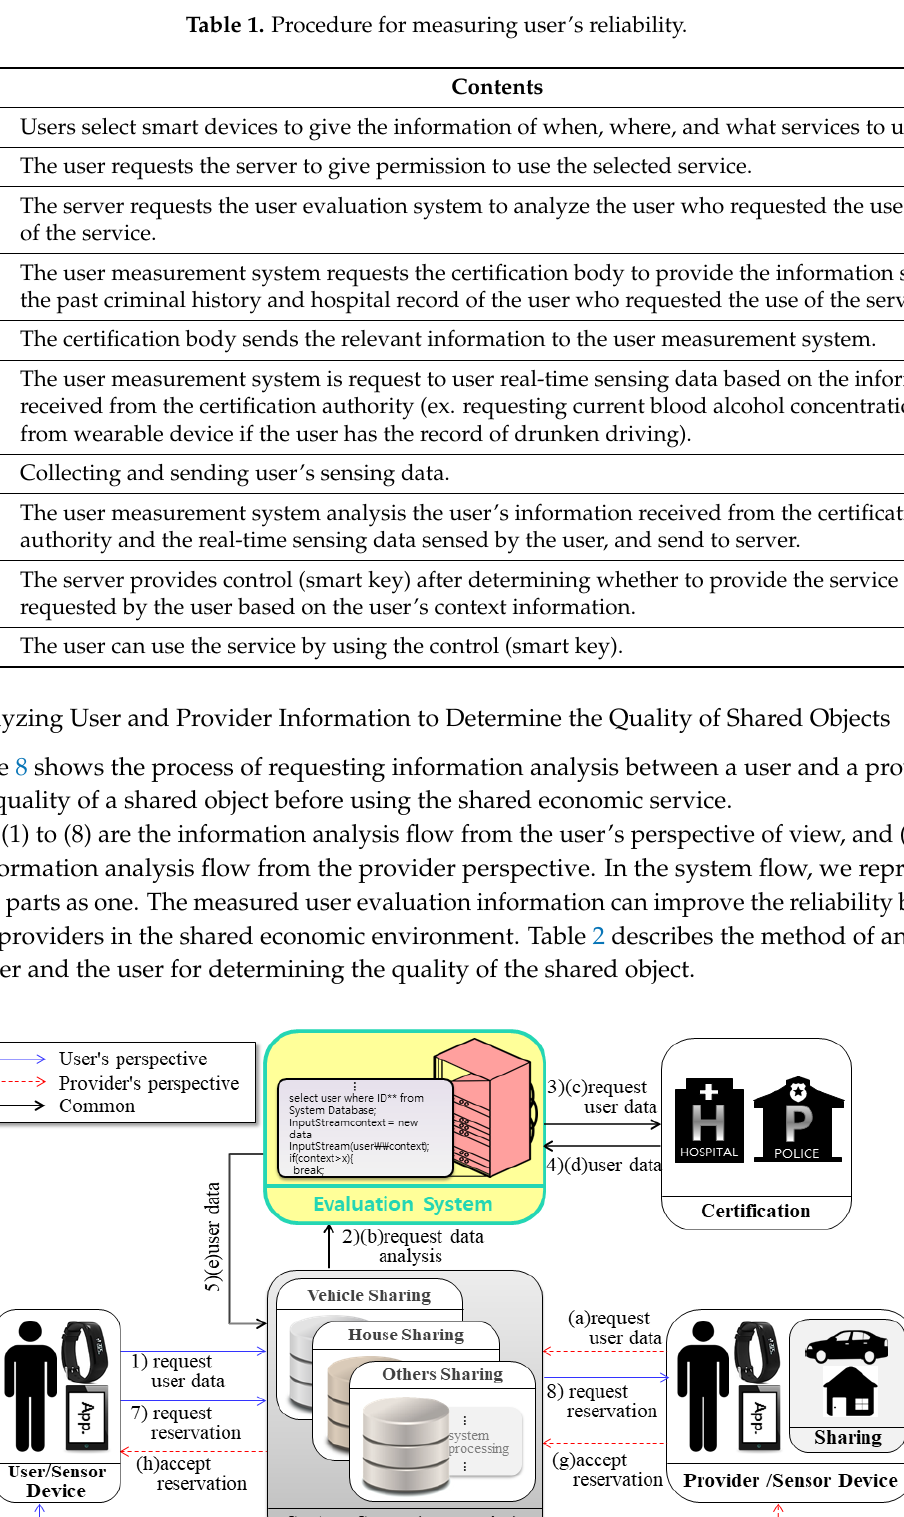
Table 1. Procedure for measuring user’s reliability.